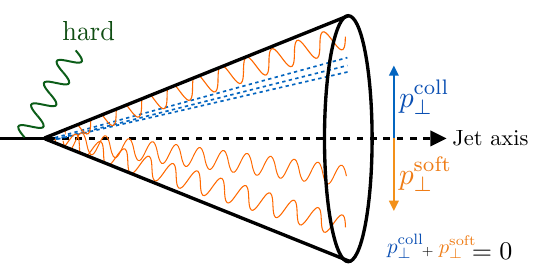
Figure 2 . Illustration of the refactorized expression of the jet function r R . Hard radiation at the jet scale p T R is allowed outside the observed jet. The collinear (cid:28) radiation (blue) is o(cid:11)set from the jet axis, due to the recoil from the soft radiation (orange) inside the jet, since the jet axis is along the jet